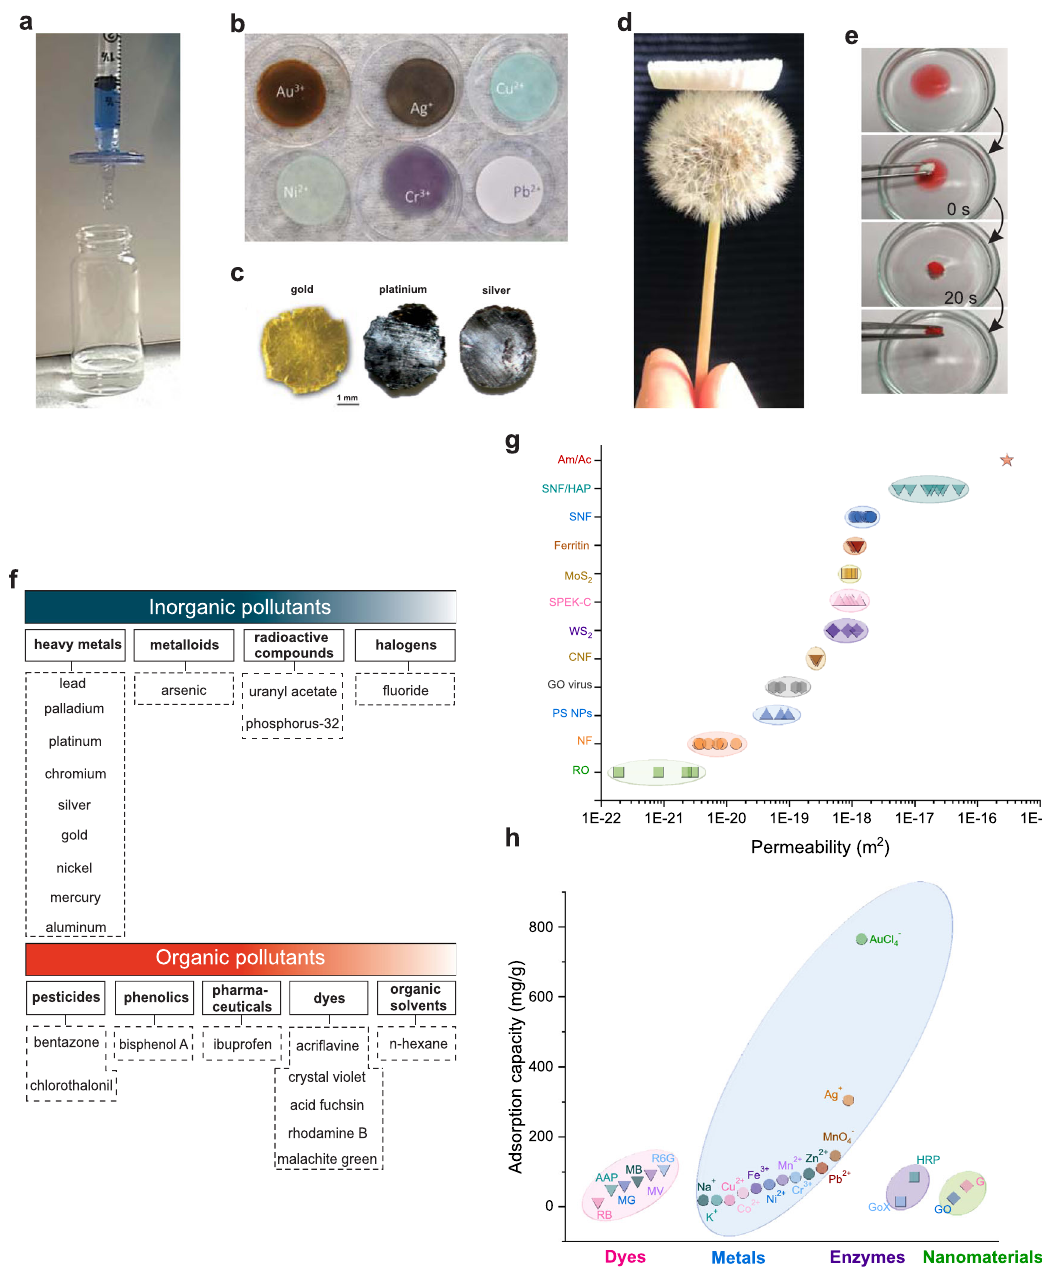
Fig. 3 Protein nano fi brils as water puri fi cation agents. a Image of hybrid silk nano fi brils/hydroxyapatite syringe membrane for the removal of Alcian Blue 8GX from water. b Image of hybrid silk nano fi brils/hydroxyapatite membrane after the adsorption of different metal ions. c Visual appearance of the elemental precious metals recovered from saturated hybrid membranes based on β -lactoglobulin amyloid fi brils. d Image of β -lactoglobulin amyloid fi brils aerogel on top of dandelion fl ower seeds. e A rapid removal of n-hexane (stained with Sudan III) from the water surface by amyloid fi brils aerogel within 20 s. f Various water pollutants that so far have been removed from water by amyloid fi brils. g Comparison of intrinsic water permeability of hybrid amyloid/activated carbon membranes with the typical commercial NF and RO membranes, as well as the most advanced, recently reported ultrathin membranes (GO graphene oxide, PS NPs polystyrene nanoparticles, CNF carbonaceous nano fi ber, SPEK-C sulfonated polyetherketone with cardo groups, SNF silk nano fi brils, HAP hydroxyapatite, Am β -lactoglobulin amyloid fi brils, Ac activated carbon) 22,31,38 . h BSA amyloid fi brils fi lm adsorption capacity for dyes (CR Congo red, MG malachite green, RB rhodamine B, MB methylene blue, R6G rhodamine 6G, AAP 4-aminoantipyrine), metal ions, enzymes (HRP horseradish peroxidase, Gox glucose oxidase), and nanomaterials (G graphene, GO graphene oxide) 29 . Panels a and b reprinted from ref. 31 . ©